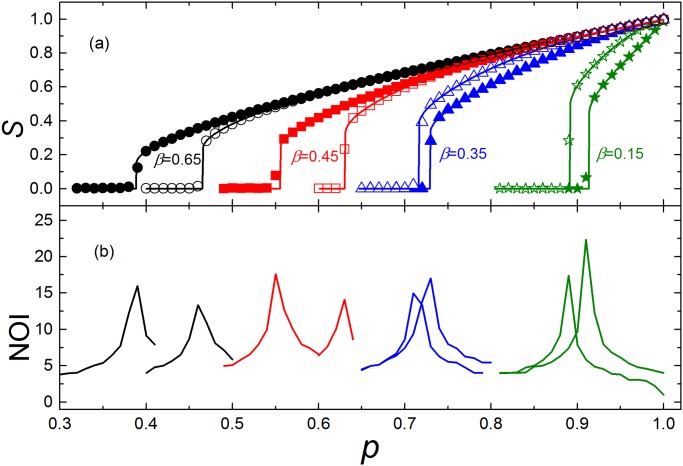
The results of ER networks with 20000 nodes for different g.In the simulation, the parameters are set as: ⟨k⟩ = 6, g = 5 (solid symbols) and g = 10 (empty symbols). (a) The size of the giant component S versus p, the fraction of nodes that have been left after random removal. The symbols represent simulation results, and the solid lines show the corresponding analytical predictions of Eq (9). When β = 0.15, 0.35, networks become more robust with g increaseing. However, for β = 0.45, 0.65, networks become more fragile with g increaseing. (b) NOI sharply increases when p approaches the critical point, so the sharp peaks can identify the corresponding critical points pcI for the first order transition region.